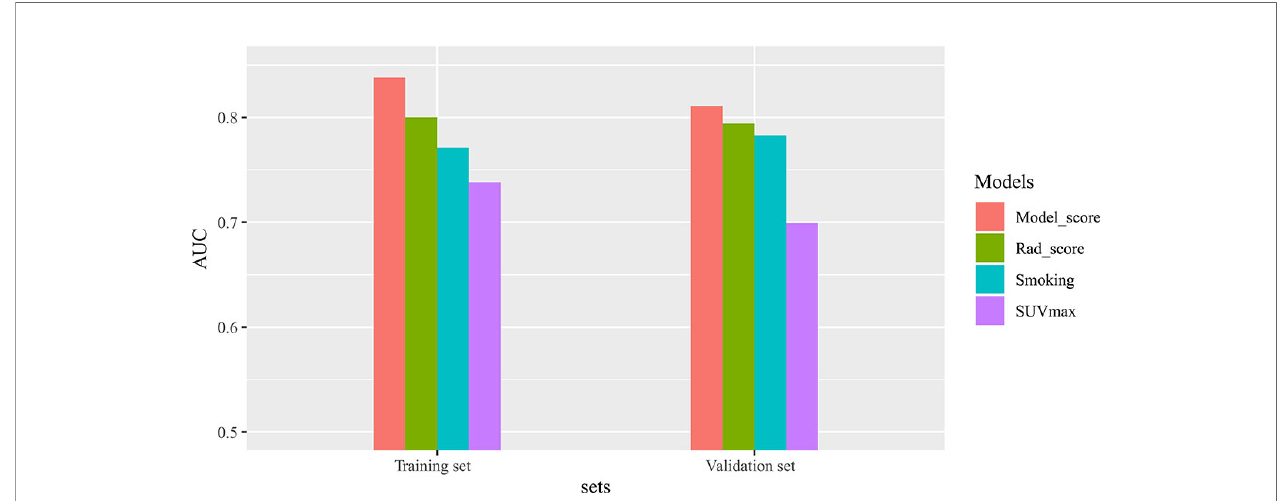
FIGURE 4 | The differences of area under the receiver operating characteristic (ROC) curve (AUC) values in different variables. There are signi fi cant differences in AUCs between Model-score and smoking in both the training and validation